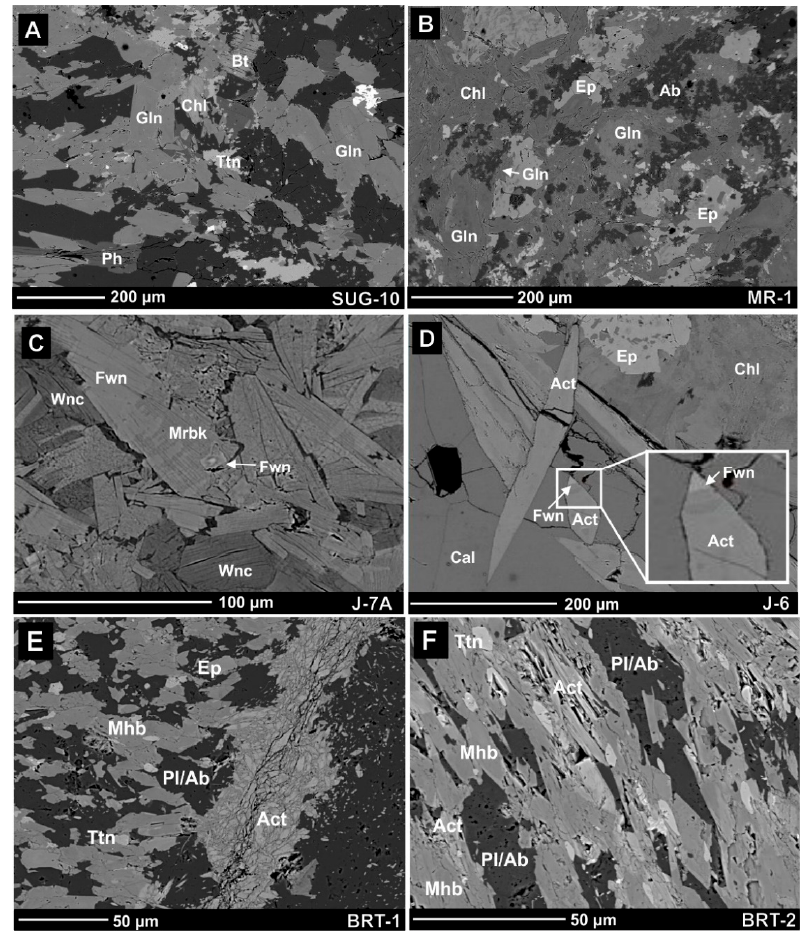
Figure 17. BSE images from the Bôrka Unit ( A ) and Jaklovce Unit ( B – F ) metabasites: ( A ) Gln–Ph assemblage of the peak (D1) metamorphic stage from blueschist in the Šugov Valley near Medzev village; ( B ) high-pressure Gln metabasite in Malý Radzim at Brdárka; ( C , D ) Jaklovce medium-to high-pressure Fwn / Wnc to Mrbk metabasalts; ( E , F ) Mhb amphibolites from the Bretka ophiolitic block hanging wall with a retrograde Act, Ab, Ep and Ttn greenschist facies overprinting.